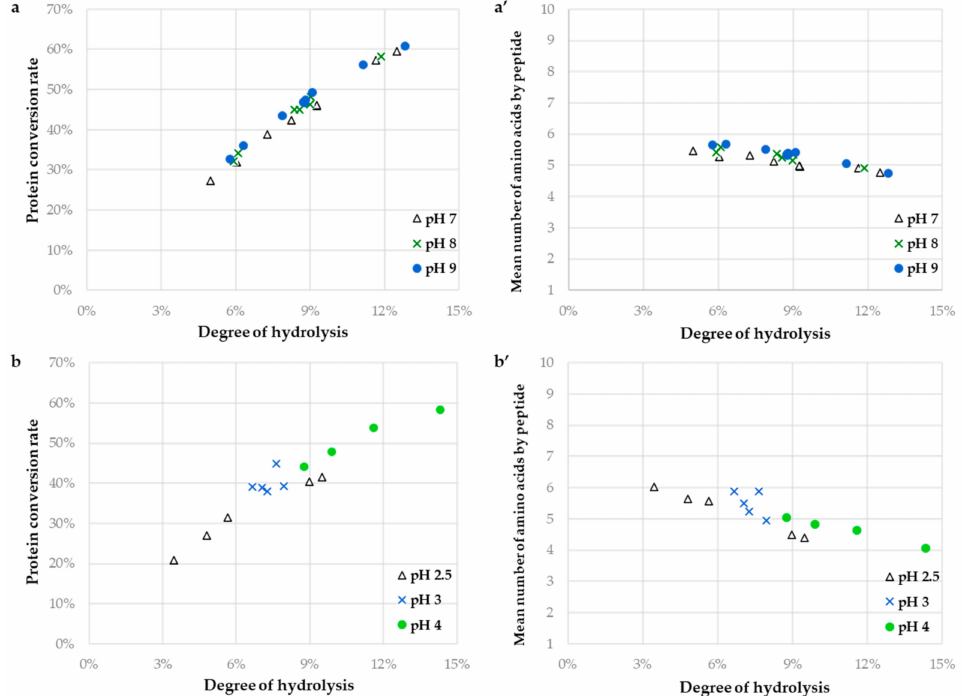
Figure 2. Protein conversion rate (( a , b ); %) and mean number of amino acid by peptide ( a’ , b’ ) for the hydrolysis of the sunflower protein isolate (1%, w / v ; in terms of protein content, N × 5.6) with Alcalase ( a , a’ ) and with Prolyve ( b , b’ ) as a function of the degree of hydrolysis as determined by size exclusion chromatography, for the different pH values of hydrolysis [ ∆ , pH 7.0; green x, pH 8.0; blue